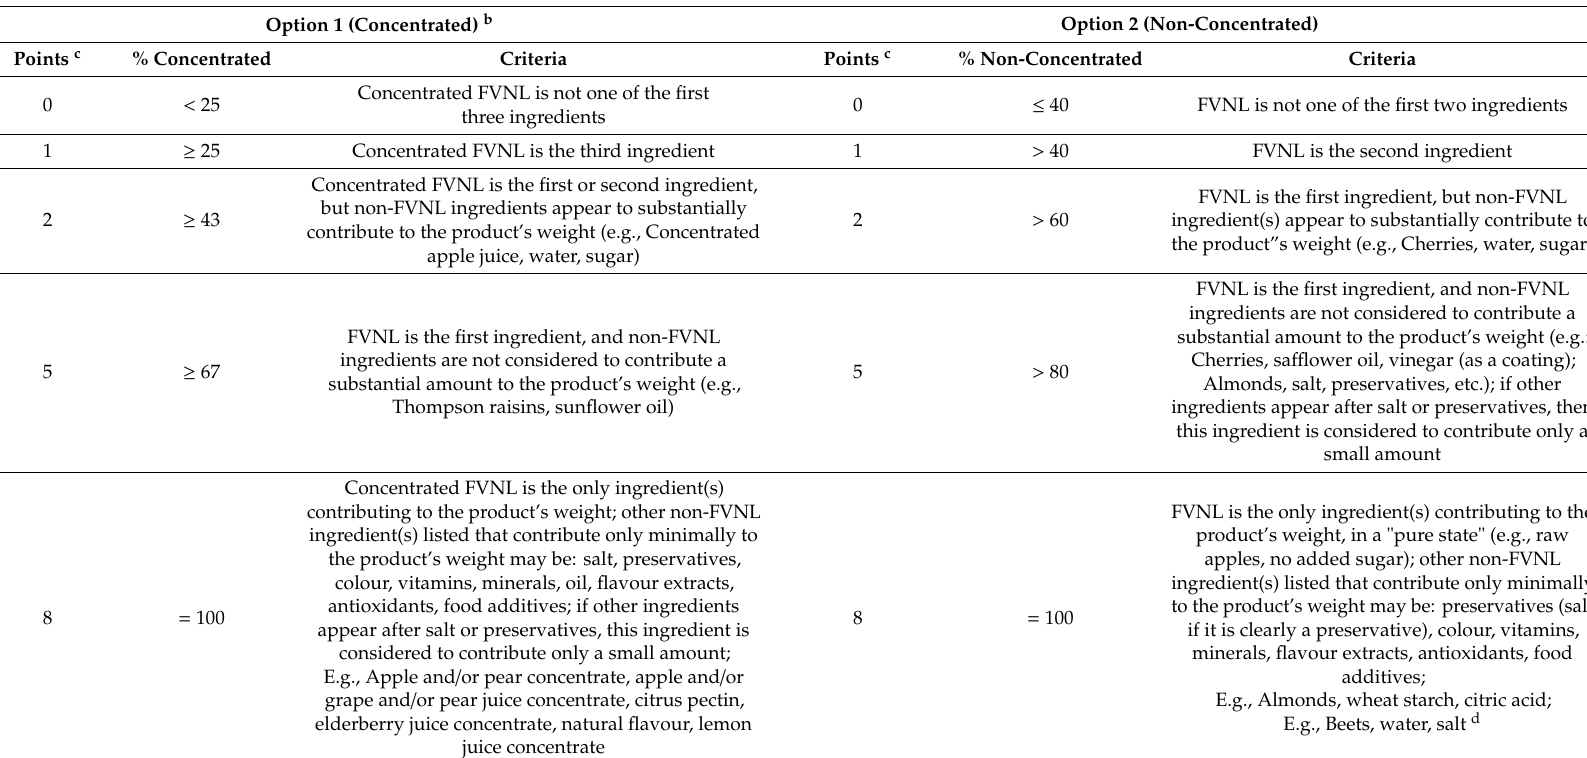
Table 2. Overview of the criteria used for estimating the contents of fruit, vegetable, nut and legume (FVNL) of products according to the Food Standards Australia New Zealand Nutrient Profiling Scoring Criterion (FSANZ NPSC) and the Health Star Rating (HSR) system a